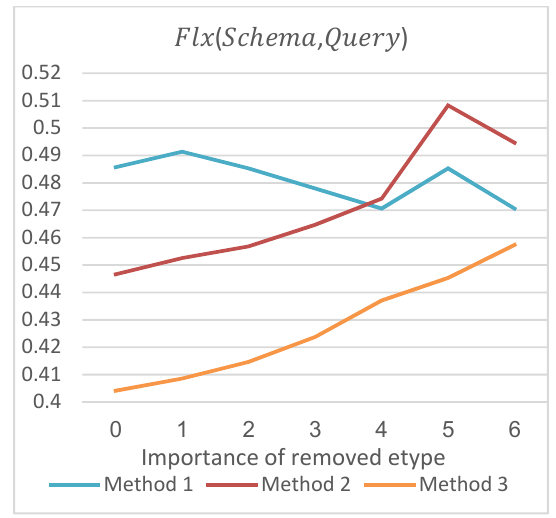
Figure 10. Flexibility of Schema to Query.